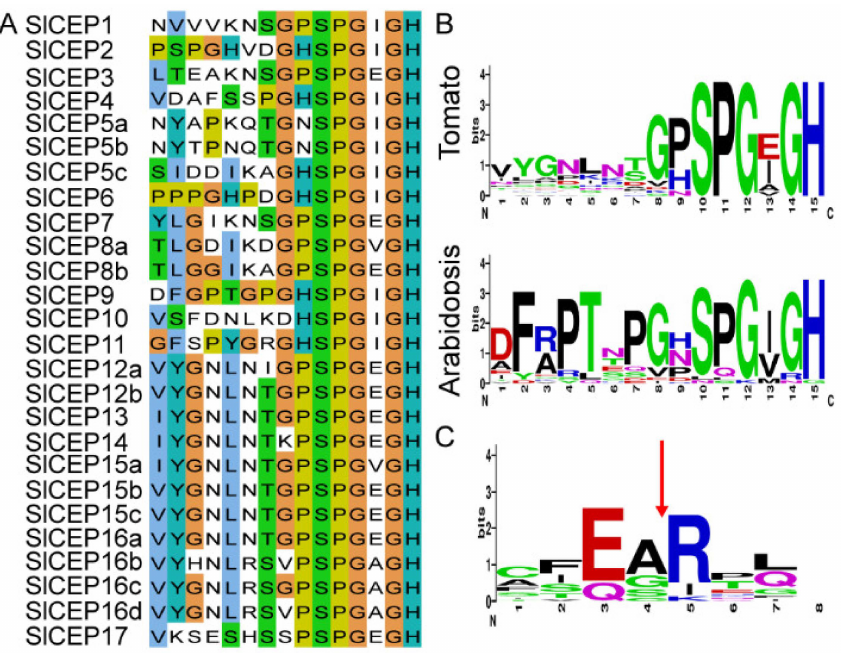
Figure 1. Identification of tomato CEP genes. ( A ) Alignment of CEP motifs of SlCEP genes. ( B ) Weblogo showing the consensus sequence of CEP motifs in tomato and Arabidopsis . ( C ) We- blogo showing the N-terminal signal peptide cleavage site of SlCEP